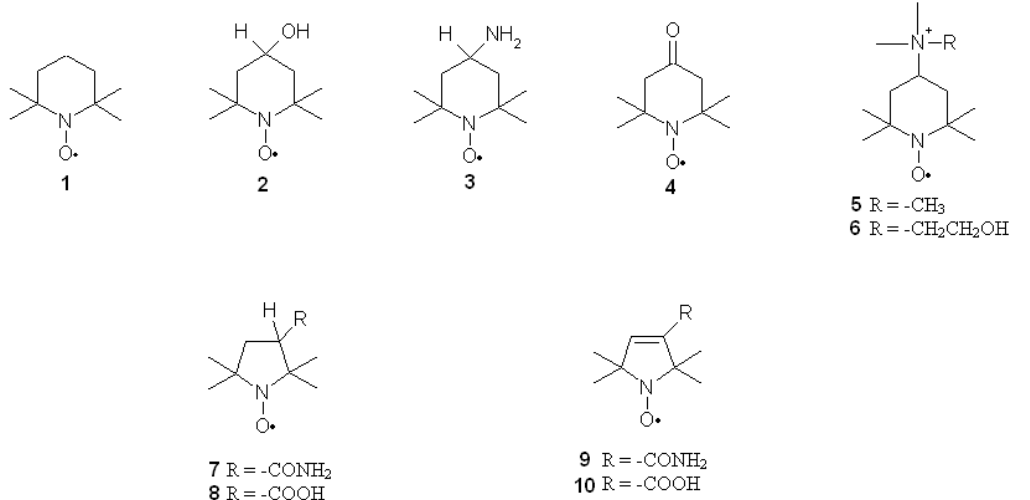
Figure 1. Most commonly used piperidine, pyrroline and pyrrolidine nitroxides: ( 1 ) Tempo, ( 2 ) Tempamine, ( 3 ) Tempone, ( 4 ) Tempol, ( 5 ) CAT-1, ( 6 ) Tempocholine, ( 7 ) Pirolid,